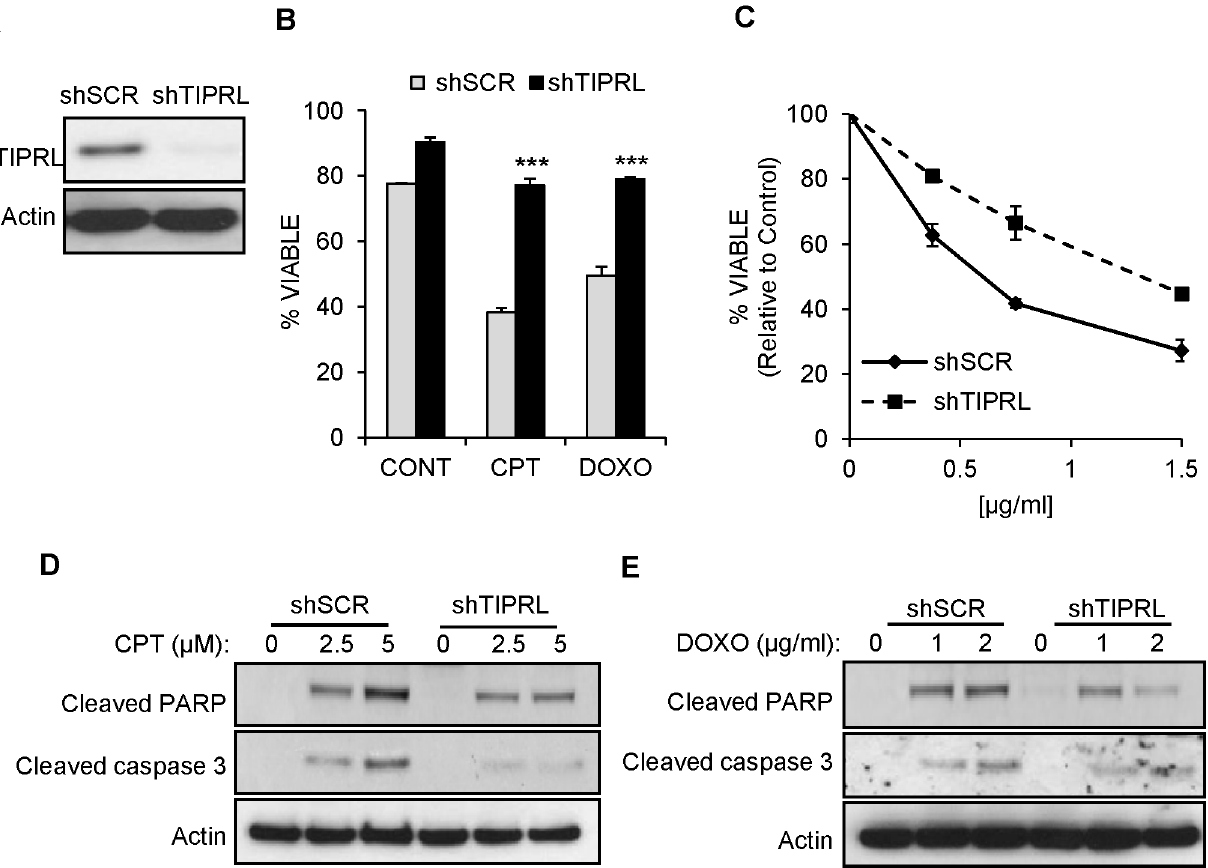
Fig 6. Knockdown of TIPRL protects from cell death in response to genotoxic stress. (A) 3T3 MEFs expressing a short hairpin against scramble (shSCR) or TIPRL (shTIPRL) were immunoblotted with the indicated antibodies. (B) 3T3 MEFs expressing a short hairpin against scramble (shSCR) or TIPRL (shTIPRL) were treated with 10 μ M CPT or (2 μ g/ml) doxorubicin (DOXO) for 24hrs. Cell viability was measured using propidium iodide exclusion. Data represent ± standard deviation of the mean of three independent experiments. (C) 3T3 MEFs expressing a short hairpin against scramble (shSCR) or TIPRL (shTIPRL) were treated with the indicated amounts of doxorubicin (DOXO) for 24hrs. Viability was determined by MTS assay. (D) 3T3 MEFs expressing a short hairpin against scramble (shSCR) or TIPRL (shTIPRL) were treated with the indicated amounts of CPT or (E) doxorubicin (DOXO) for 24hrs and PARP and caspase 3 cleavages were evaluated by immunoblotting. *** p < 0.001, Student ’ s t